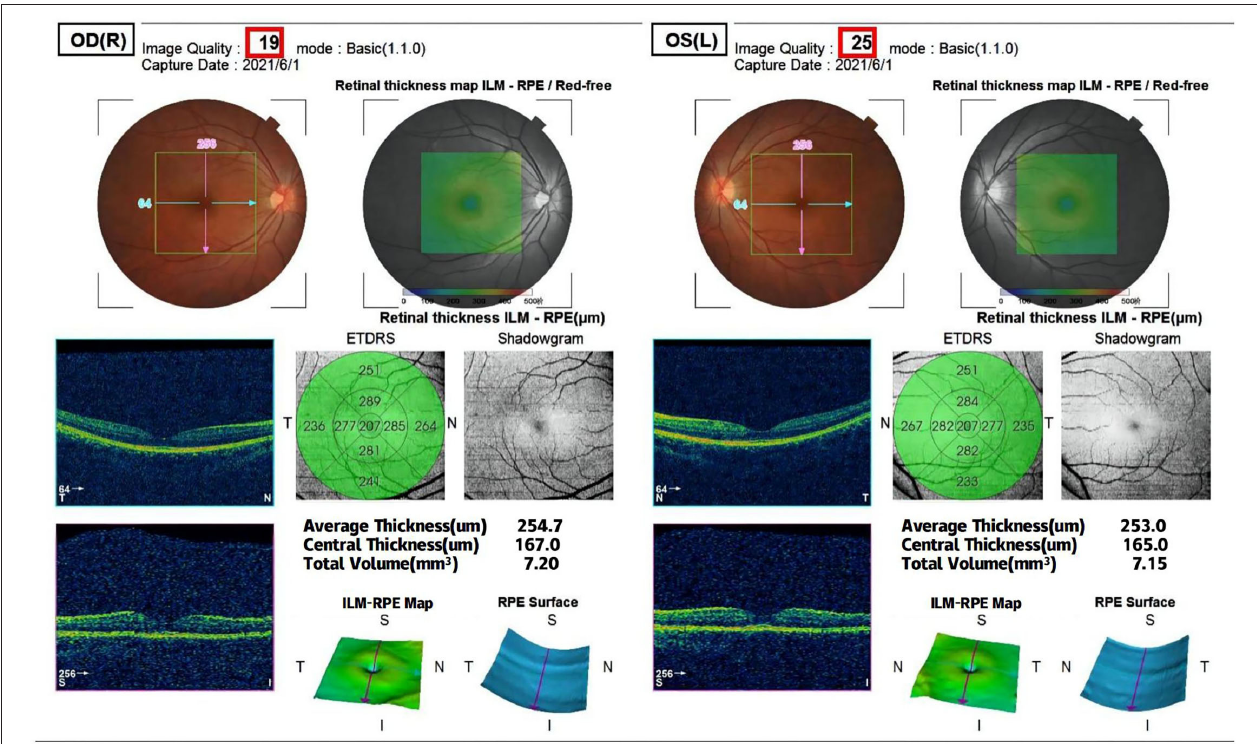
FIGURE 4 | The OCT examination of retinal thickness in the macular region.